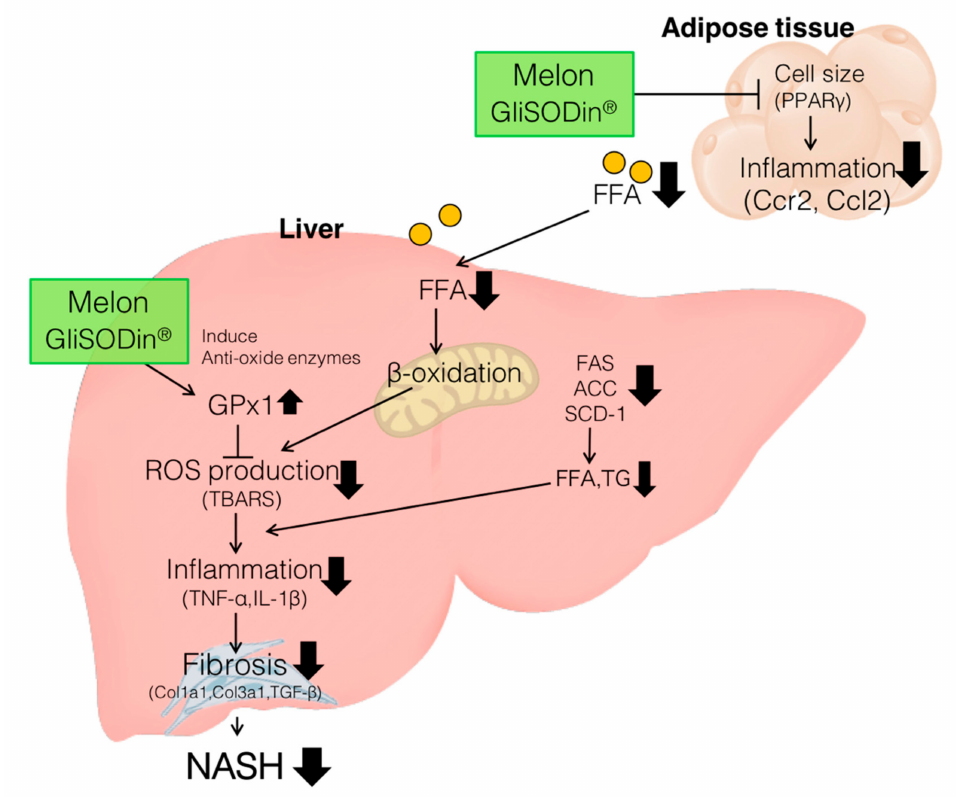
Figure 5. Suggested mechanism for the prevention of NASH by Melon GliSODin ®